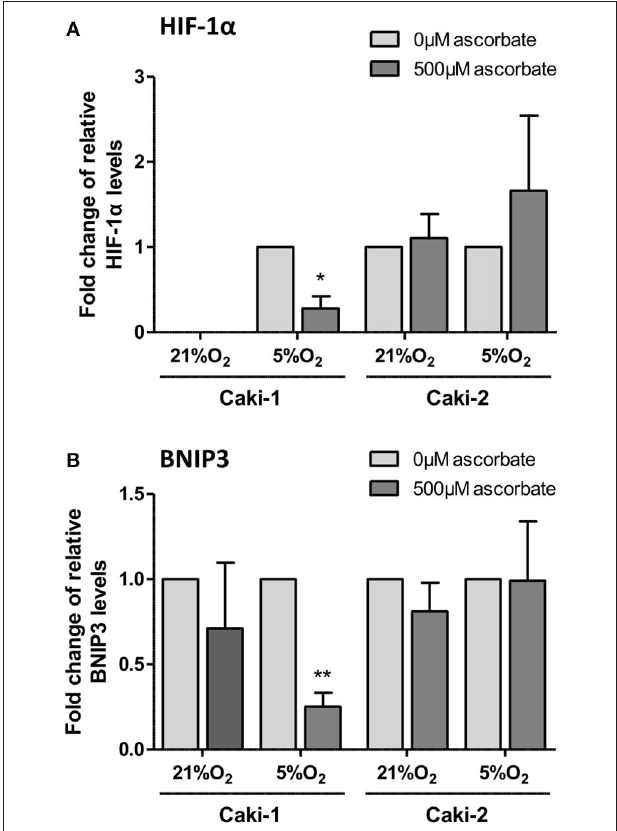
FIGURE 5 | HIF pathway expression in ccRCC cell lines in response to ascorbate. Caki-1 (VHL-proficient) and Caki-2 (VHL-defective) cells were pre-loaded with 500 µ M ascorbate for 16h, or left untreated, and then subjected to 21% O 2 or 5% O 2 for 8h. Protein levels of HIF-1 α and BNIP3 were evaluated by Western blot analysis with β -actin as loading control. Densitometry analysis shows protein levels standardized to β -actin and relative to untreated cells (0 µ M ascorbate) (A,B) . Induced expression of HIF-1 α and BNIP3 in Caki-1 cells at 5% O 2 was repressed by ascorbate treatment. No significant changes in response to ascorbate were observed in Caki-2 cells. Differences between the groups were evaluated by paired t - test. Data represent mean + SD from three independent experiments; * p < 0.05, ** p <